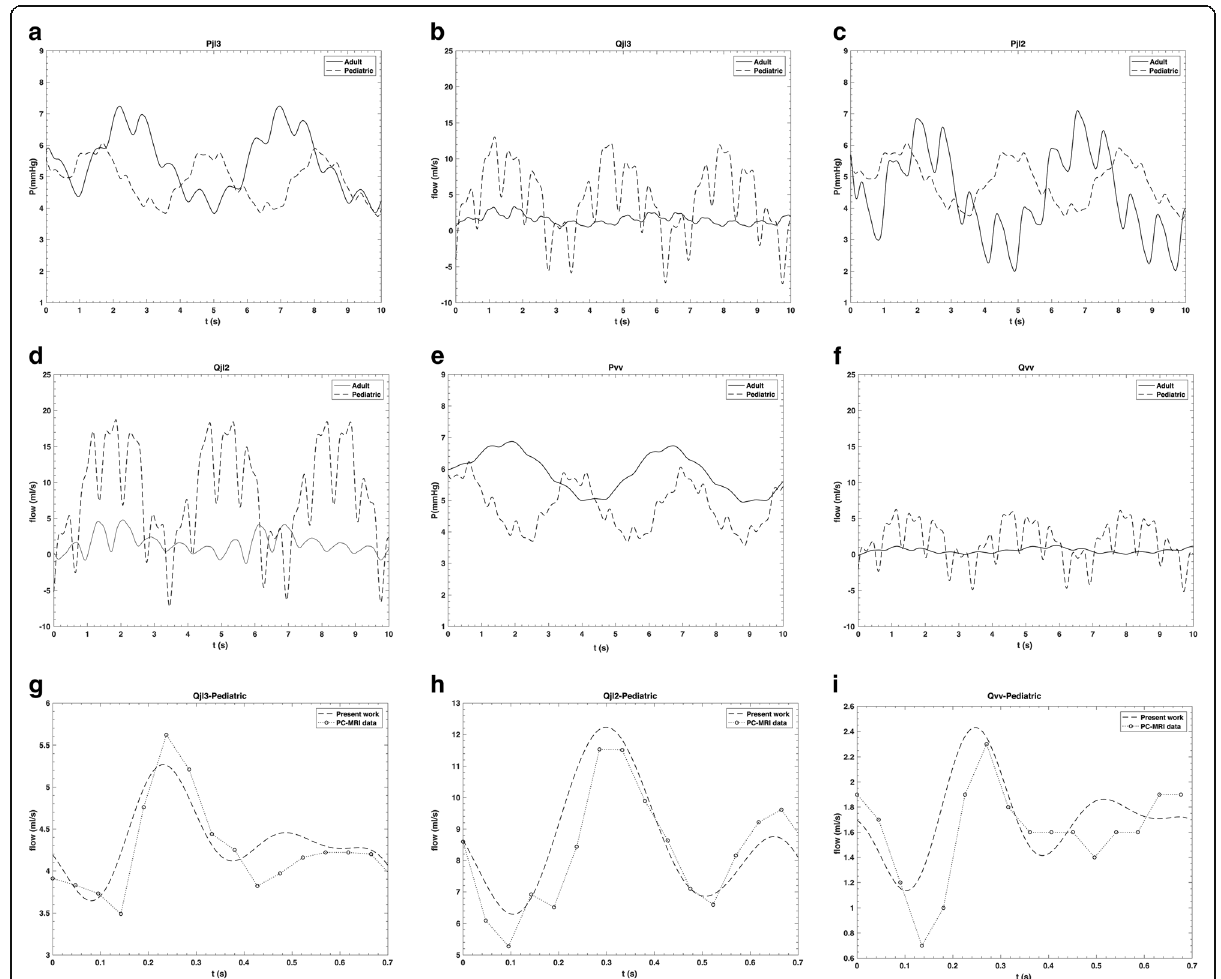
Fig. 6 Comparison of the simulated pressure and flow rate at the level of IJV and VV for paediatric (dashed line), adult (solid line), and PC-MRI data (dotted line). jl2 Middle segment of the left jugular vein, jl3 Upper segment of the left jugular vein, vv Vertebral